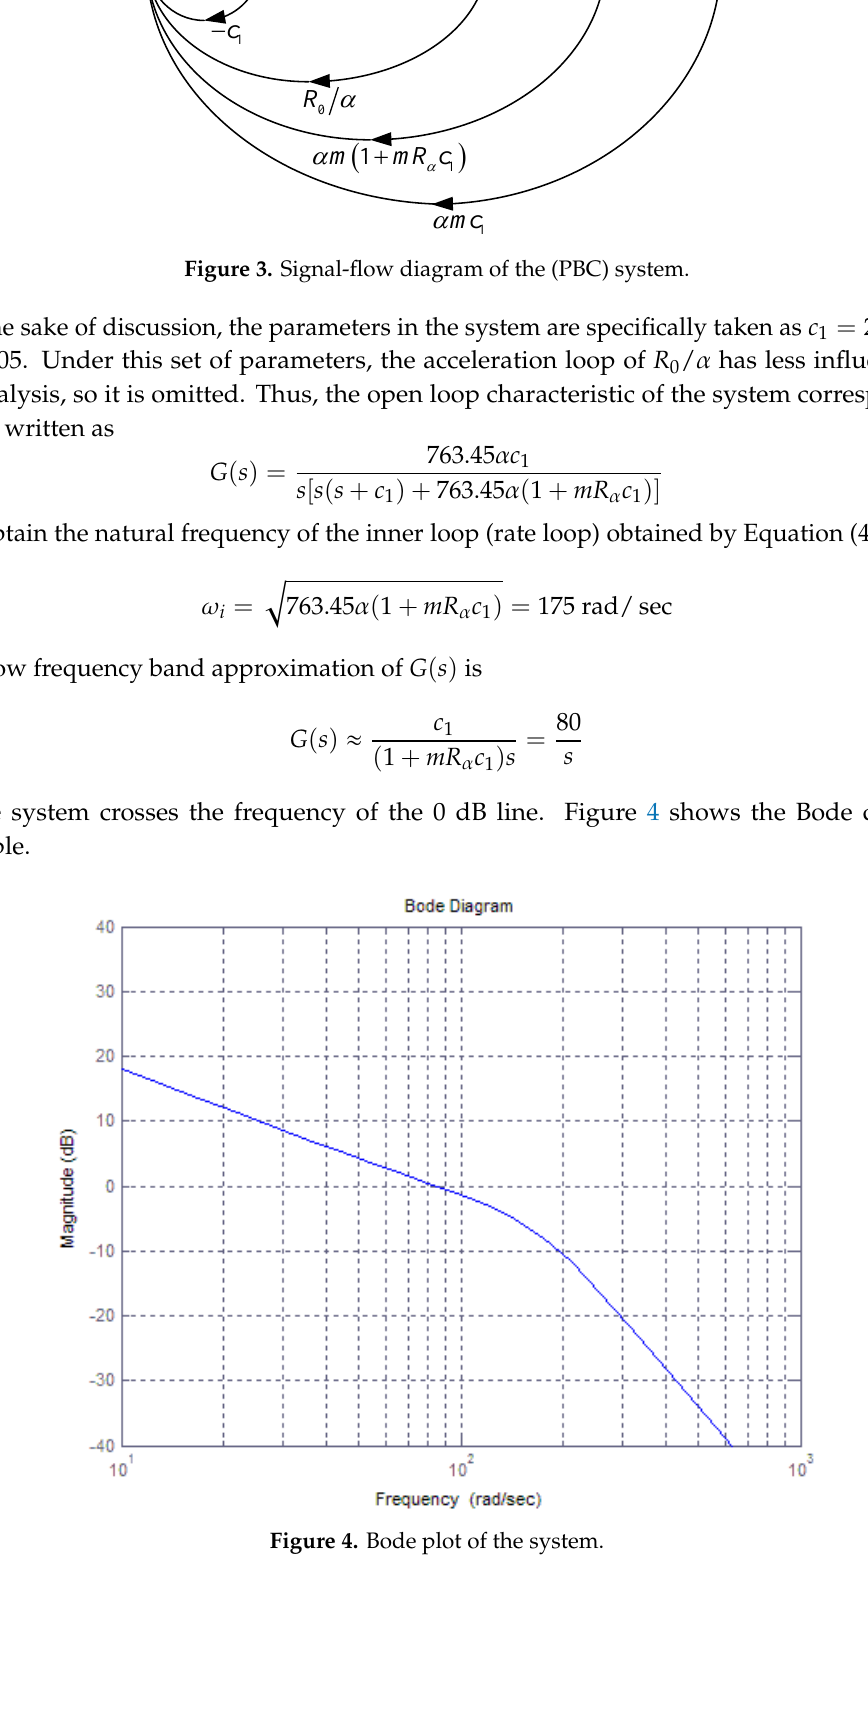
Figure 4. Bode plot of the system. 5. Discussion From the signal flow diagram and the above data, it can be seen that the roles of the interconnection and damping assignment is: